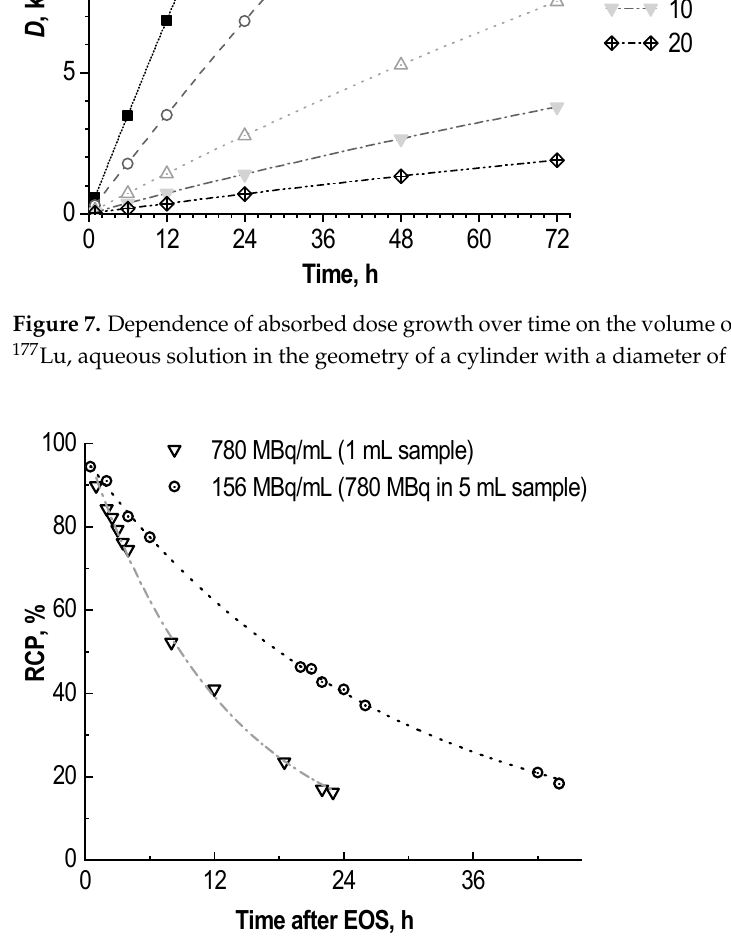
Figure 8. Comparison of radiochemical purity decrease over time for two [ 177 Lu]Lu-PSMA-617 preparations: 1 mL sample with 780 MBq of 177 Lu and identical sample diluted with water ( × 5); synthesis at 95 ◦ C for 30 min in 1 mL, 100 µ g of PSMA-617, pH 4.5, C(Na-acetate) = 0.03 mol/L (mean RCP value, n = 3).